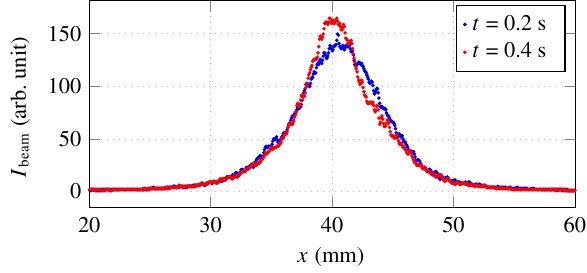
FIG. 11. Example of the evolution of the horizontal profile during pulsed cooling. Parameters as in Fig.